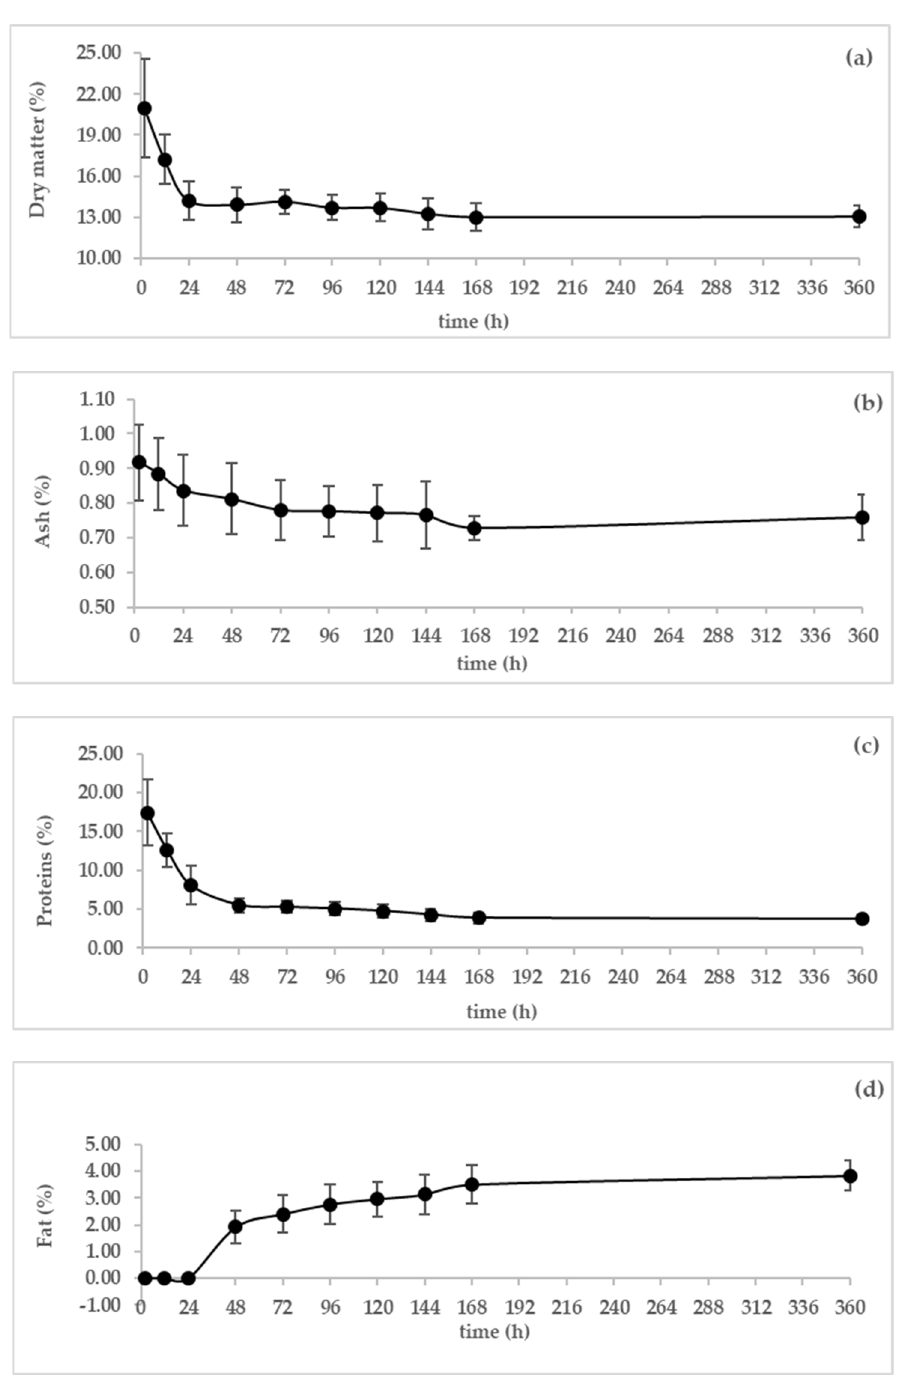
Figure 4. Variation in chemical composition of dromedary camel colostrum and milk during the first 7 days and on day 15 postpartum ( n = 16), ( a ) dry matter, ( b ) ash and ( c ) fat, and ( d ) protein. The content of camel colostrum in the dry matter, during the first day postpartum, decreased significantly from 20.95 ± 3.63% in the first two hours to 14.22 ± 1.41%